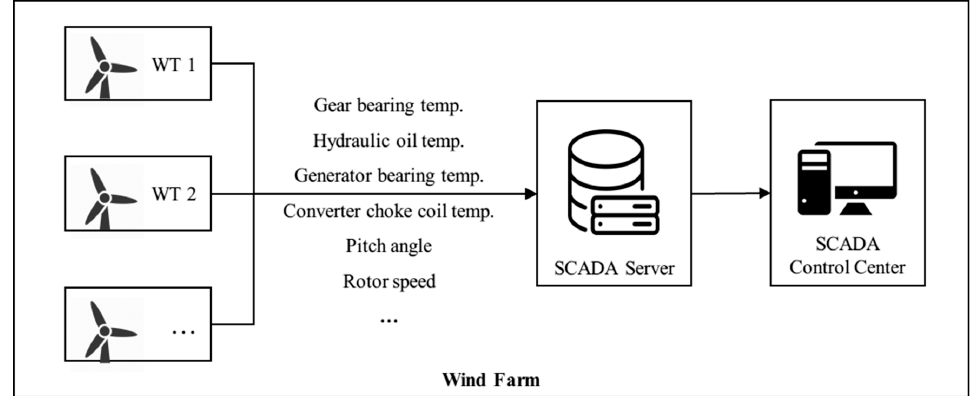
Figure 5. Data acquisition process of a WT’s SCADA system.